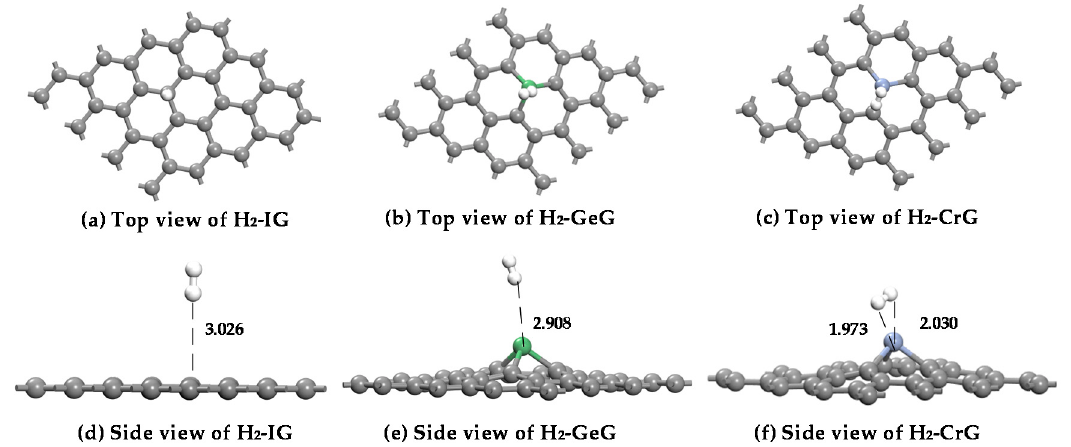
Figure 7. The optimal structures of H 2 adsorbed on IG ( a , d ), GeG ( b , e ), and CrG ( c , f ) systems.